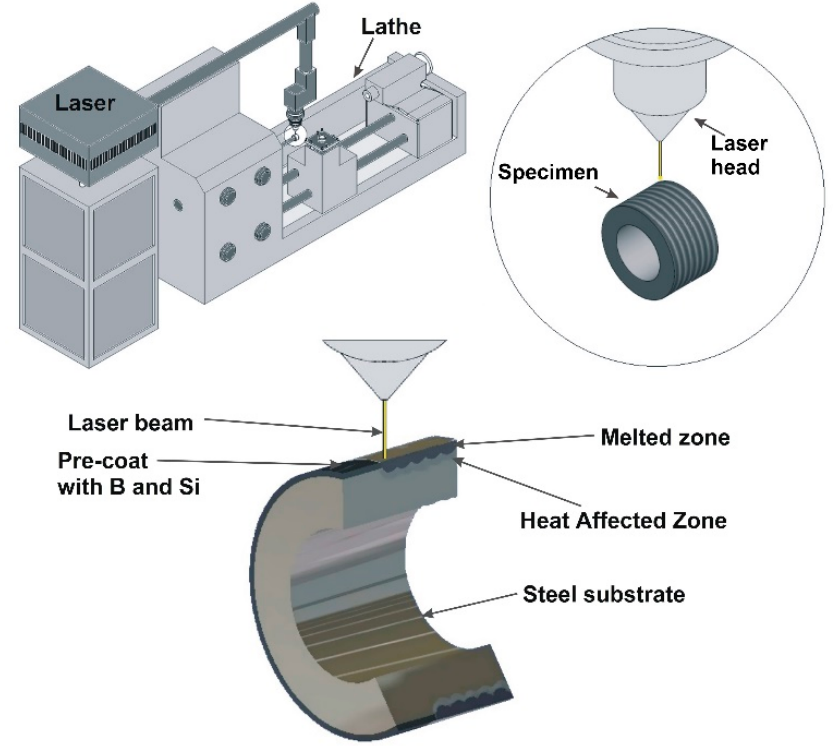
Figure 2. Scheme of the coating production process and schematic representation of the investigated